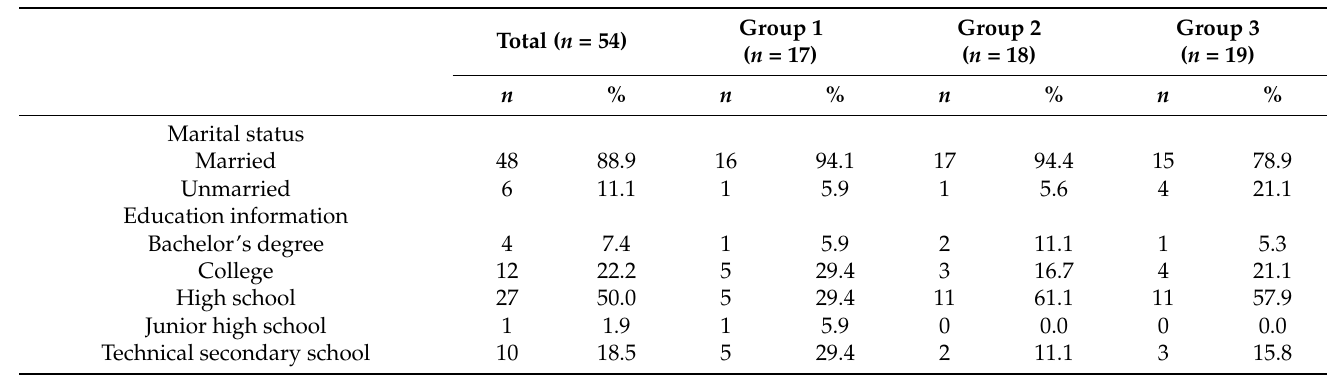
Table 2. The marital status and education information of 54 coal mine